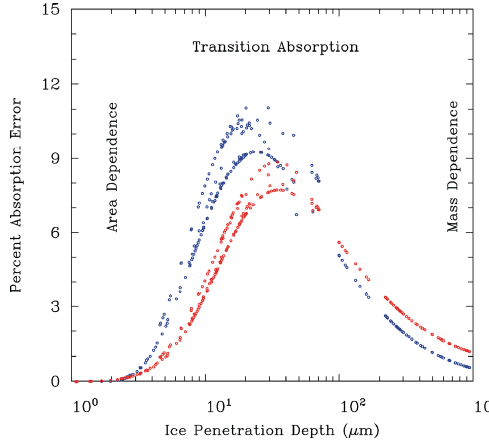
Figure 17. Absolute values of Q abs errors (relative to the measured PSD) related to the ice penetration depth at corresponding wavelengths, where blue is for the D e = 39 μ m case and red is for the D e = 101 μ m case. In each case the two PSD compared have the same ice particle shapes and tunneling contributions were removed from their optical properties so that transition absorption could be examined in isolation regarding PSD shape differences.